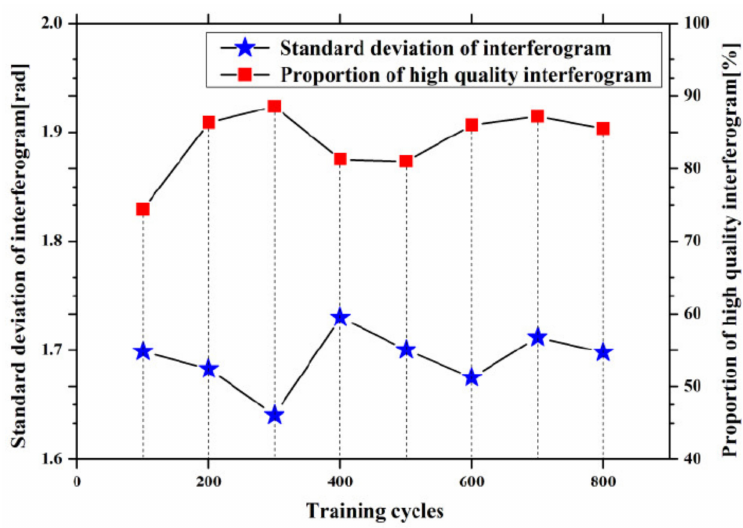
Figure 8. Training efficiency in dependency of the number of training cycles.